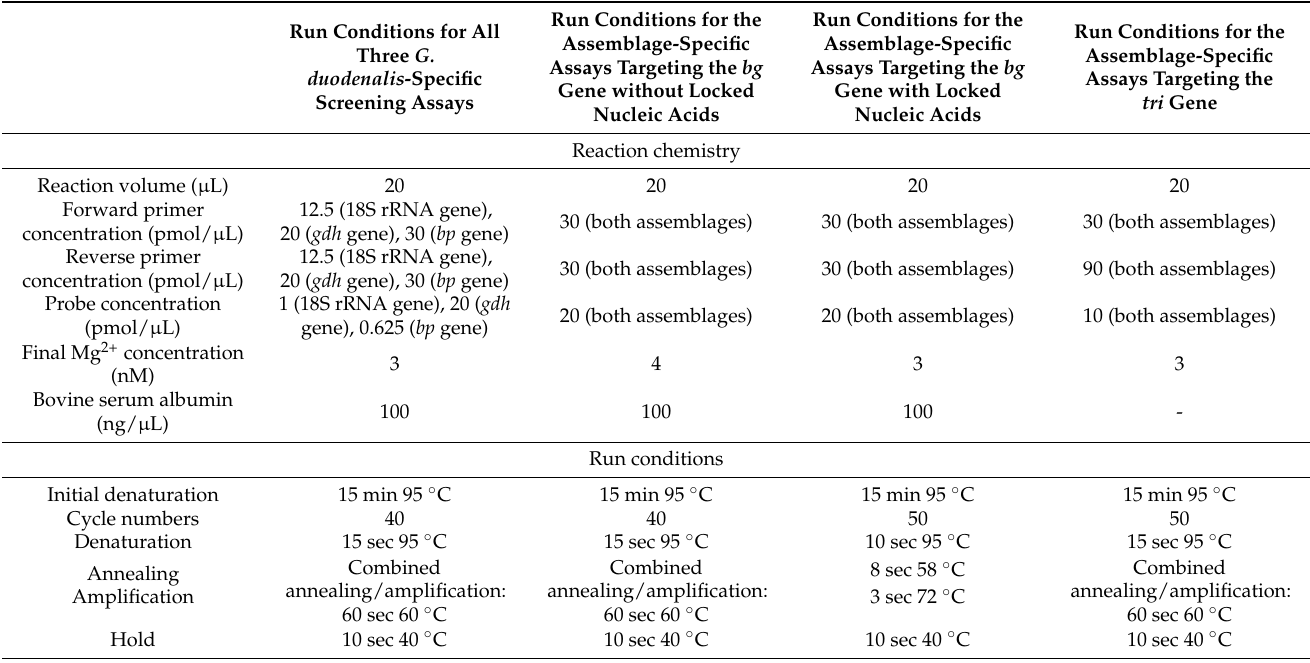
Table A2. Details of the run conditions of the compared PCR assays. All assays were run with HotStar Taq Mastermix (Qiagen, Hilden, Germany).